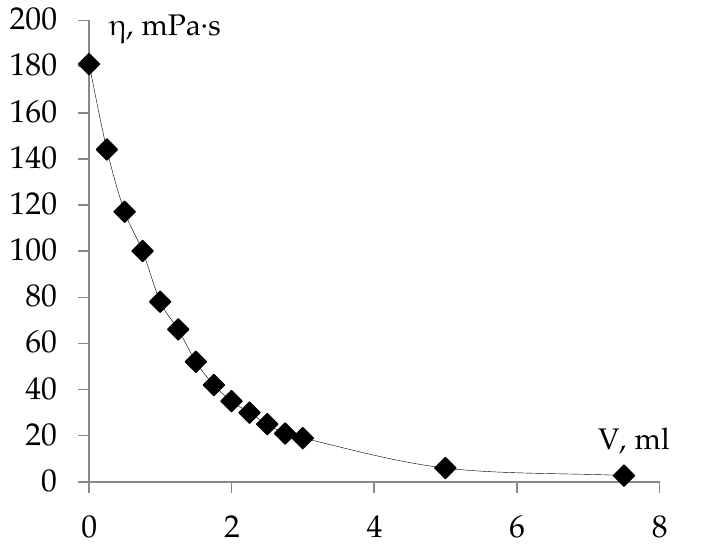
Figure 3. The dependence of the viscosity of MF-5 on dilution with kerosene. The original MF-5 sample had a significant viscosity and was unsuitable for using in microfluidic systems; therefore, the MF-6 sample was chosen as the basis for obtaining bidisperse systems. Magnetite particles (particle size is 300 nm) were added at a ratio of